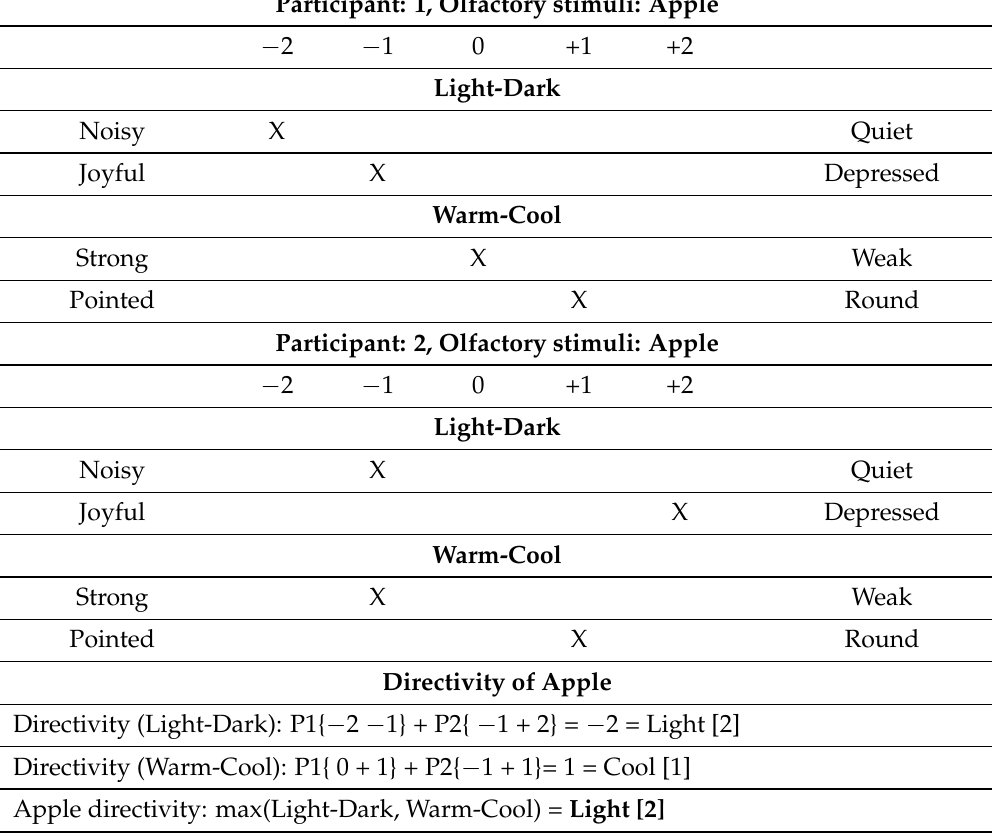
Table 9. Semantic adjectives association test example.